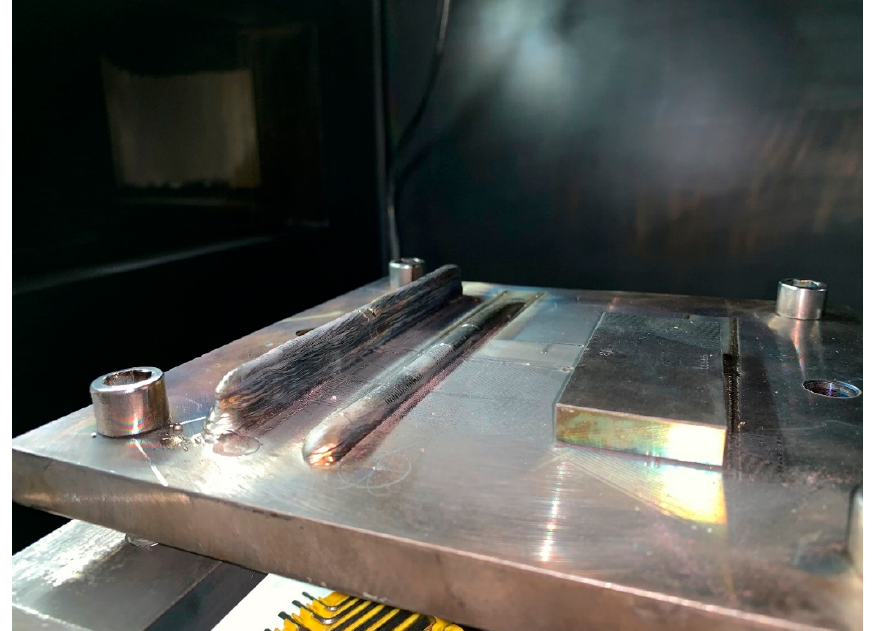
Figure 13. Deposited part to be measured. Sensors 2019 , 19 , x FOR PEER REVIEW